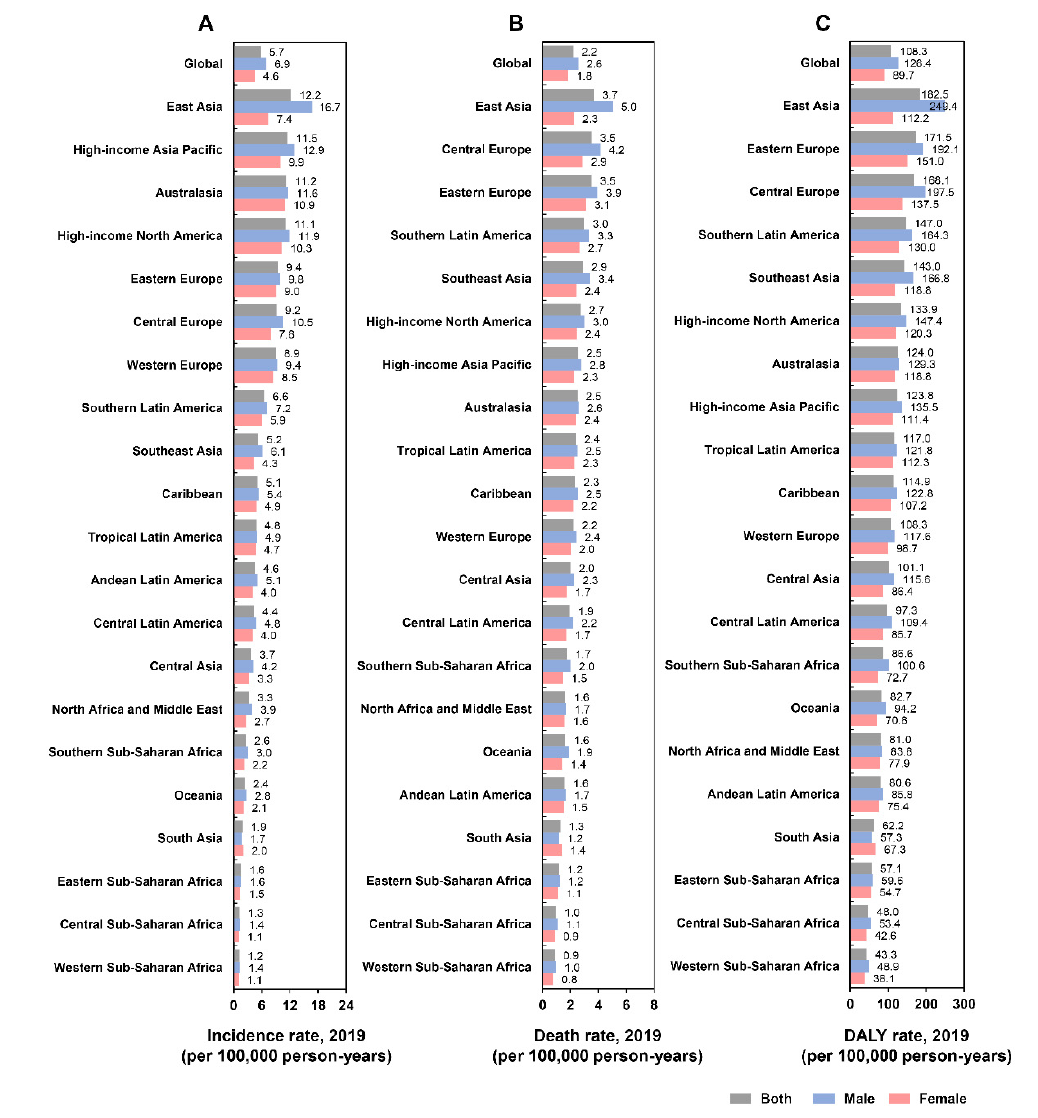
Figure 1. The incidence rate ( A ), death rate ( B ), and DALY rate ( C ) of early-onset CRC worldwide and in 21 GBD regions by sex, 2019. CRC: colorectal cancer; DALY: disability-adjusted life-year; GBD: Global Burden of Disease.